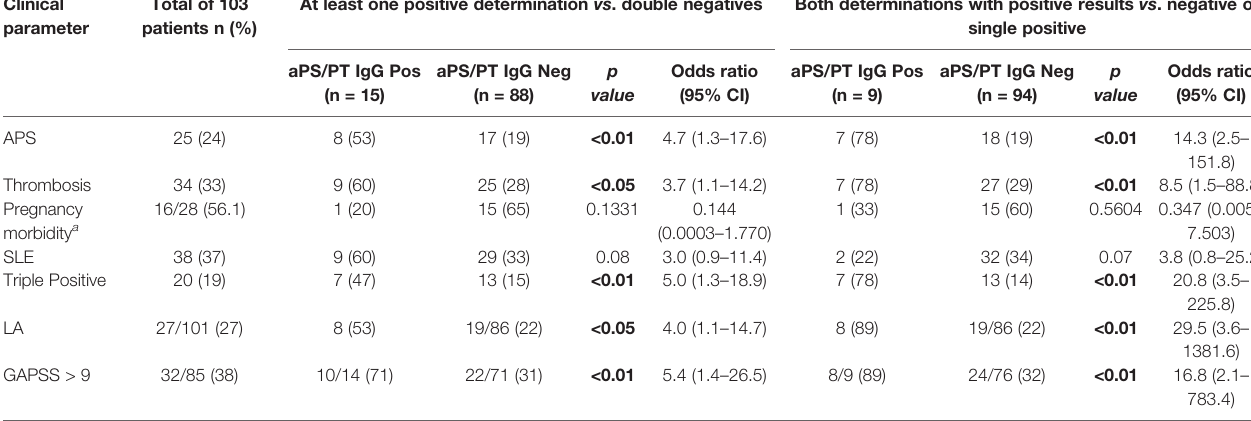
TABLE 4 | Association between aPS/PT IgG antibody positivity rate and clinical manifestations. Clinical parameter